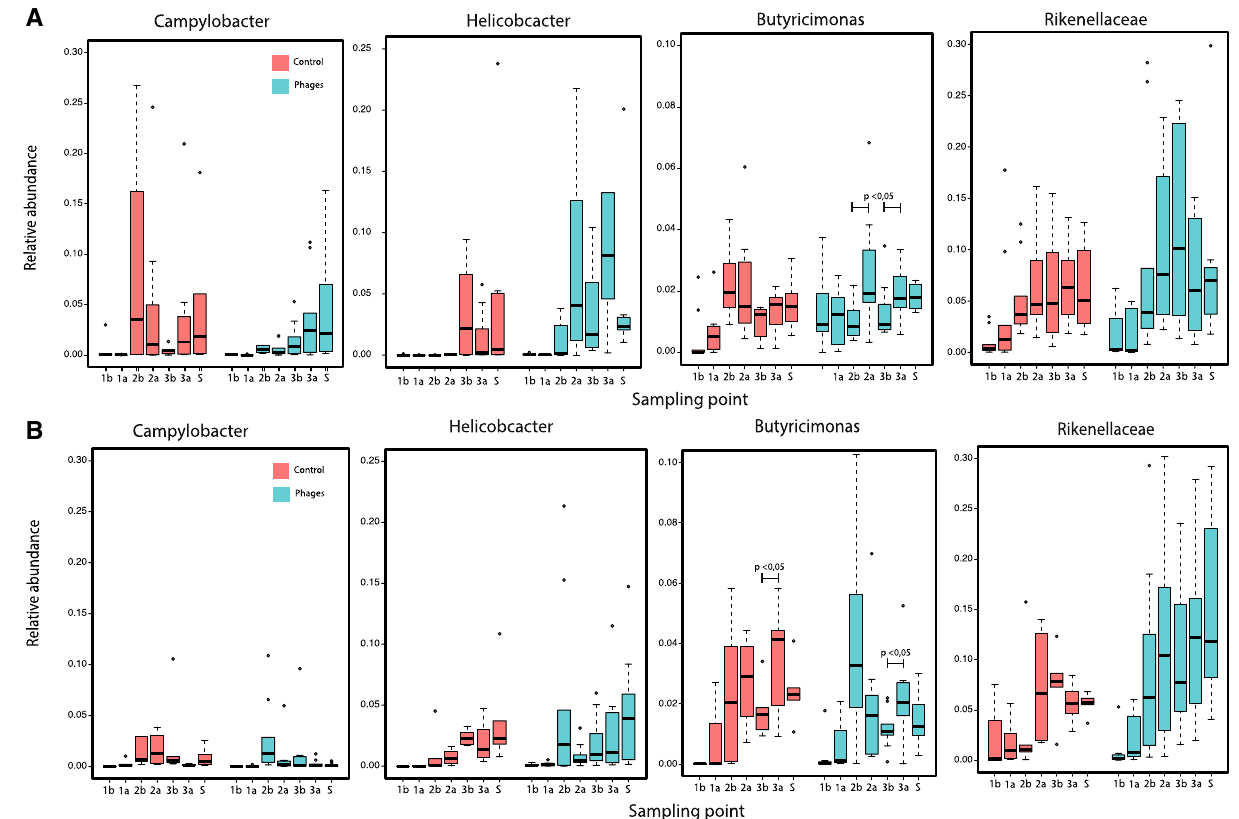
Figure 7. Relative abundance of Bacterial taxa significantly associated with the treatment. Results are discriminated by trial over time, shown as sampling point as in Fig. 1. Results are presented by Trial 1 ( A ) and Trial 2 ( B ). Control groups are depicted in salmon while treated groups are shown in blue. The body of the box plot represents the first and third quartiles of the distribution and the median line of abundance of all ASV assigned to the corresponding genera. The whiskers extend from the quartiles to the maximum or minimum data within 1.5× interquartile range, with outlayers beyond. ANOVA test P < 0.05 shows significant differences in microbial abundance of Butyricimonas before and after the dose of phages. This figure was generated using Phyloseq package in R v 1.2.5 (https:// www.r- proje ct.